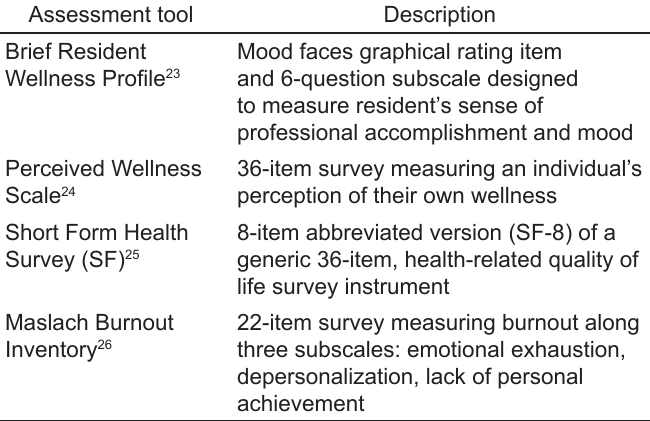
Table 2. Assessment tools used to evaluate intervention